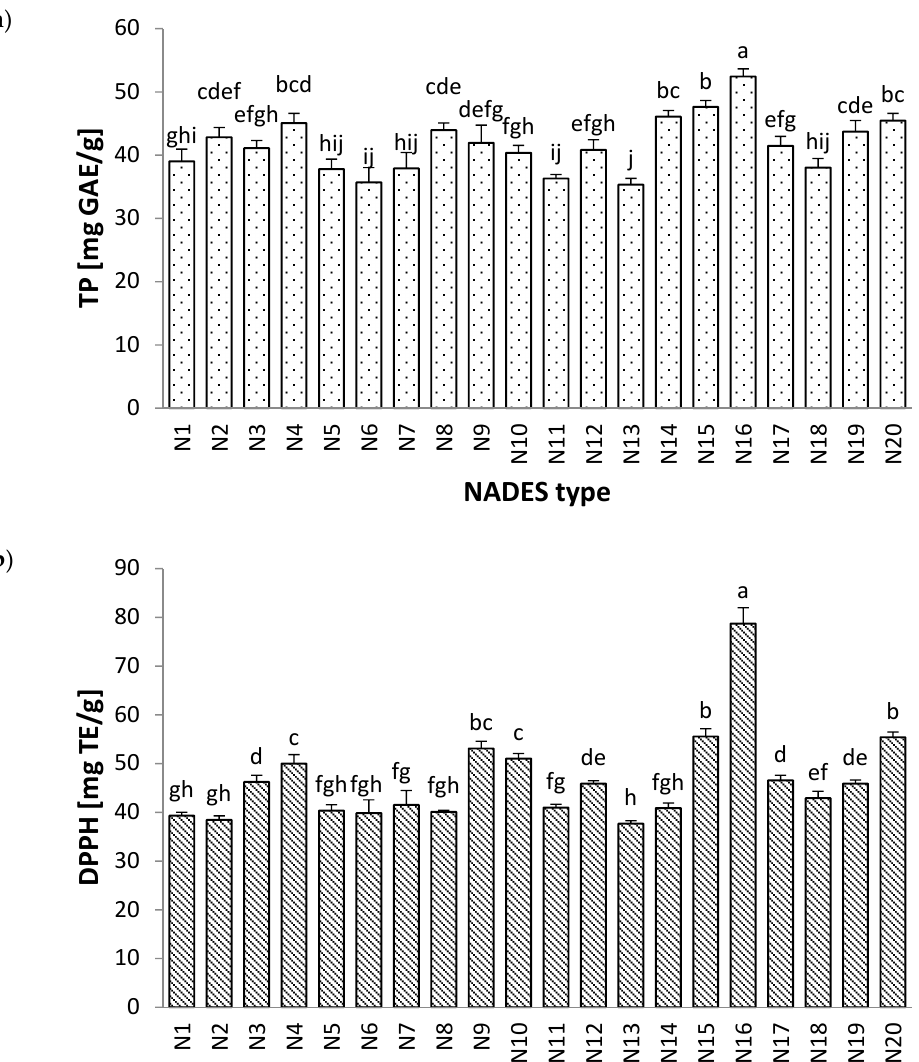
Figure 1. The effect of applied NADES on ( a ) total phenol content and ( b ) antioxidant activity toward DPPH radicals in wild thyme extracts. Results were expressed as mean ± standard deviation (SD) and different letters represent statistically significant differences ( p < 0.05) according to Tukey’s test.